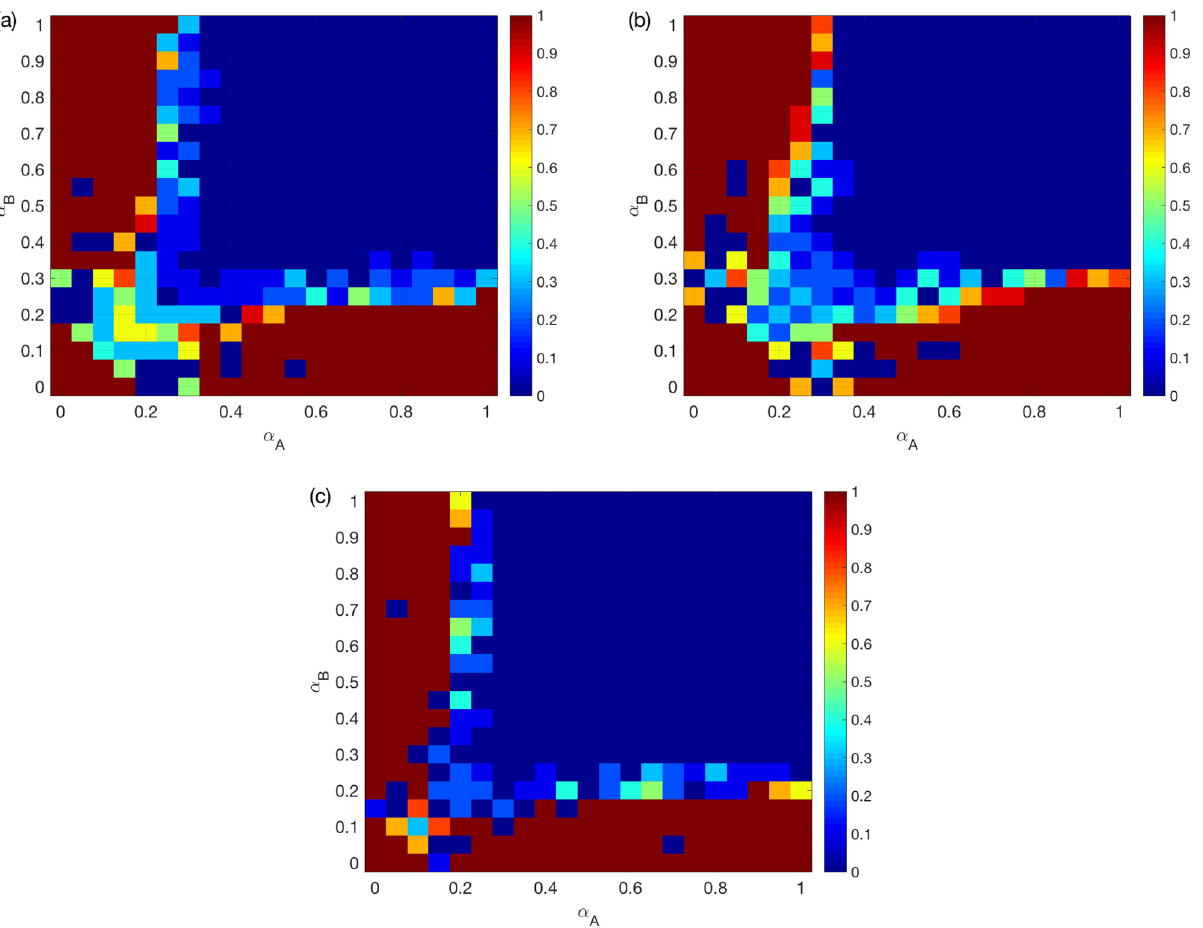
Fig 9. Best choice of overlap ratio r for two SF networks, SUM rule. (a) N = 1000, averagedover M = 30 realizations. (b) N = 2000, averagedover M = 30 realizations. (c) N = 3000, averagedover M = 5 realizations k A = k B = 6. The color for different α A and α B values indicatesthe optimal r that leads to the largest mean G